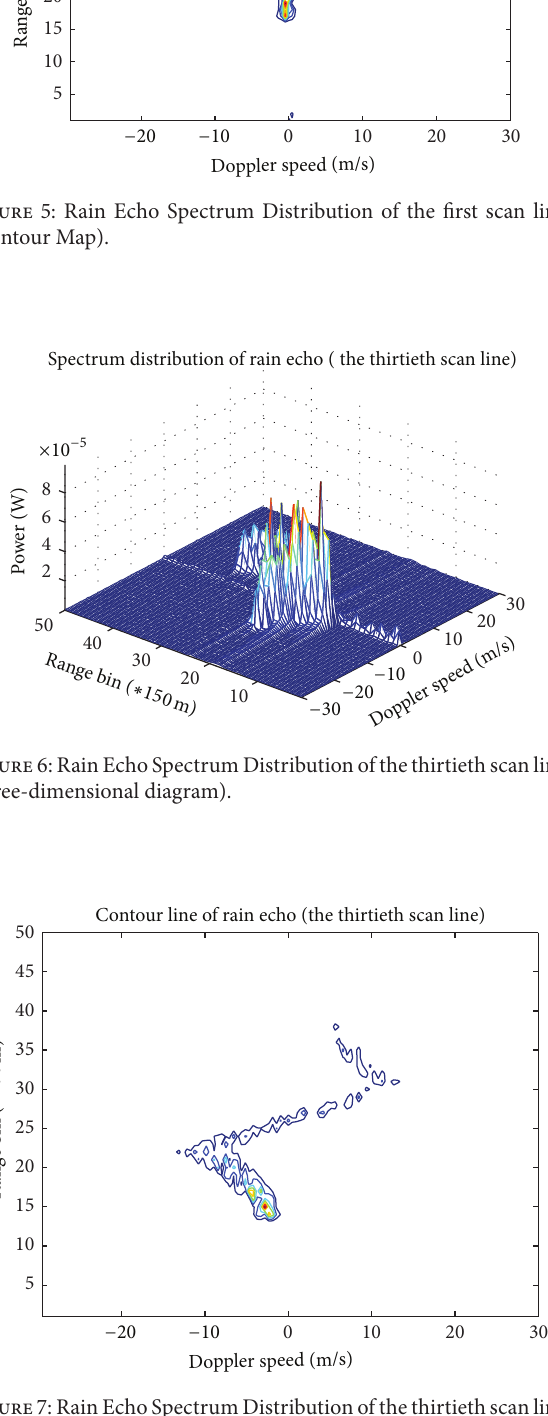
Figure 7: Rain Echo Spectrum Distribution of the thirtieth scan line (Contour Map).